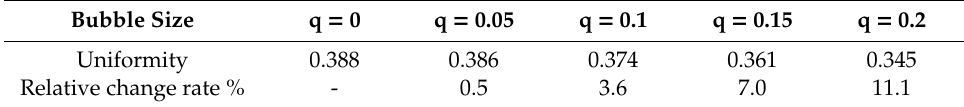
Table 1. The uniformity of weight function at